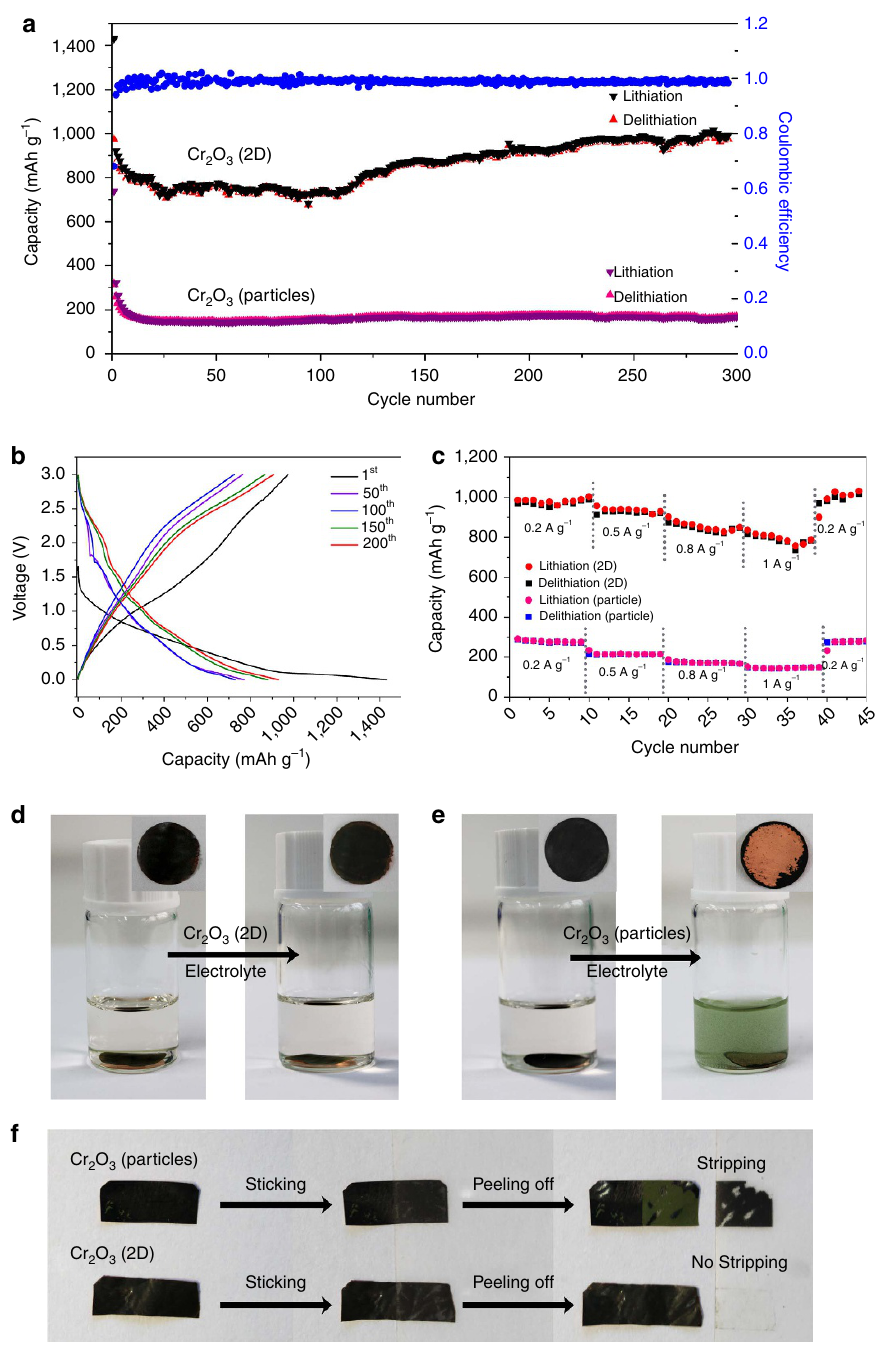
Figure 3 | Electrochemical and adhesion performance of chromic oxides. ( a ) The cycling performance of the Cr 2 O 3 electrodes. ( b ) The galvanostatic lithiation/delithiation profiles of the 2D Cr 2 O 3 electrodes. ( c ) The rate performance of the Cr 2 O 3 electrodes. ( d ) The Cr 2 O 3 (2D) electrode and ( e ) Cr 2 O 3 (particles) electrode before (left of panel) and after (right of panel) being ultrasonically cleaned in an electrolyte solution. ( f ) The Cr 2 O 3 electrodes before and after mechanical